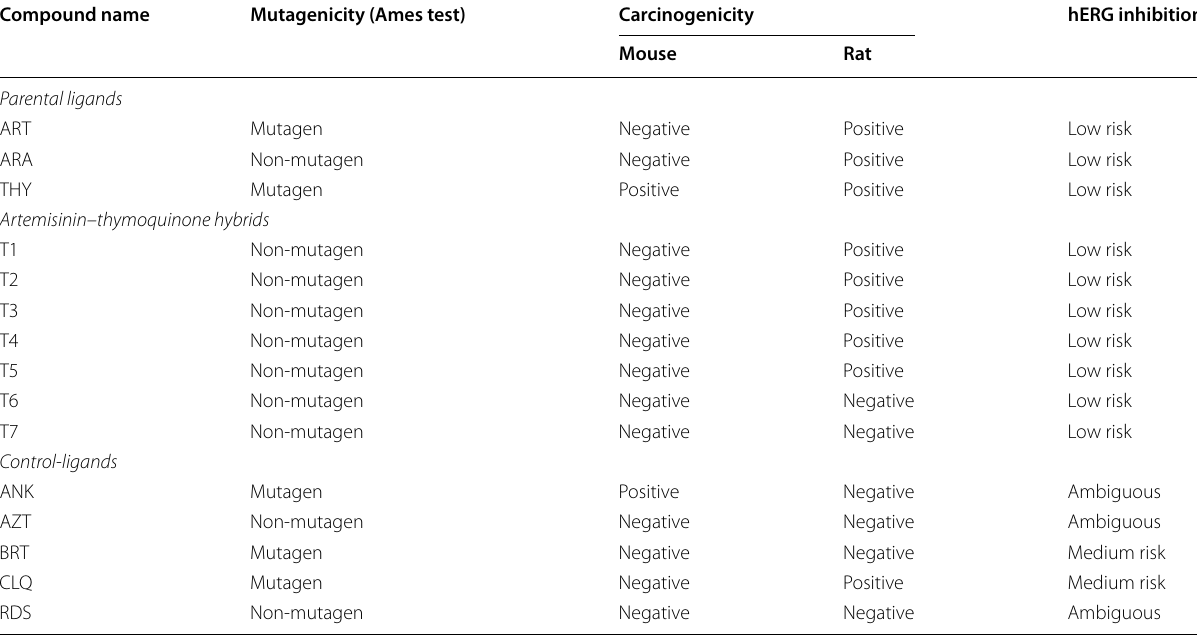
Table 4 Carcinogenicity and mutagenicity of AMES test and hERG inhibition prediction for the ART-THY hybrids, parental and control